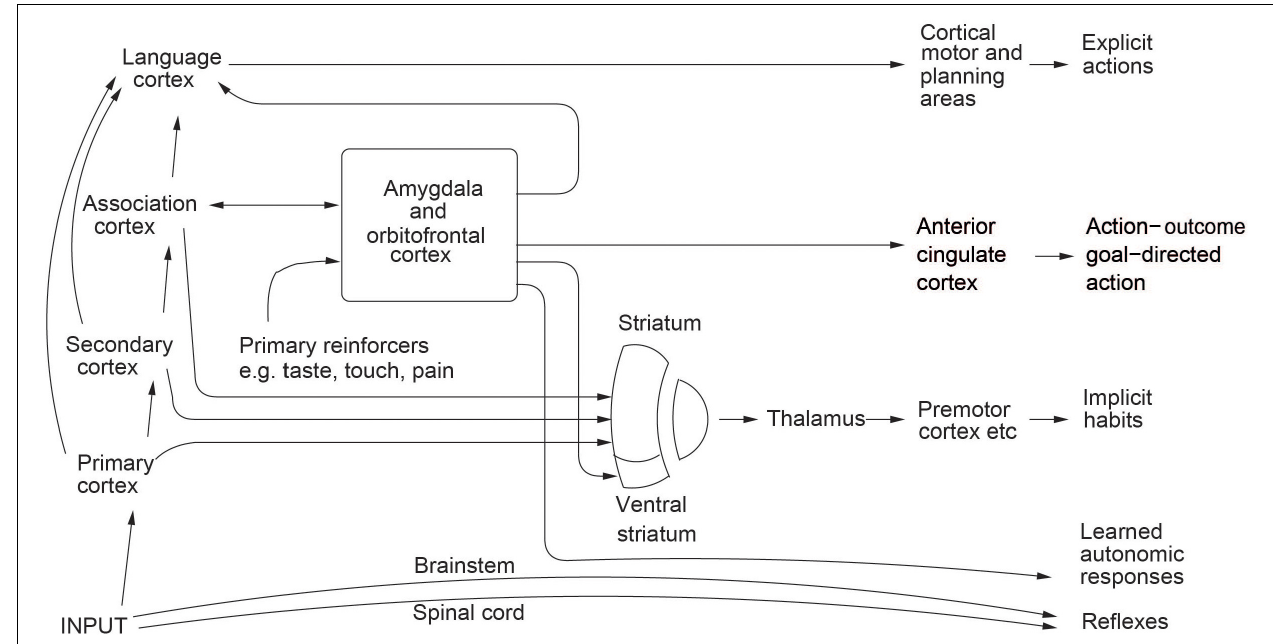
FIGURE 1 | Multiple routes to the initiation of actions and other behavioral responses in response to rewarding and punishing stimuli. The inputs from different sensory systems to brain structures such as the orbitofrontal cortex and amygdala allow these brain structures to evaluate the reward- or punishment-related value of incoming stimuli, or of remembered stimuli. One type of route is via the language systems of the brain, which allow explicit (verbalizable) decisions involving multistep syntactic planning to be implemented. The other type of route may be implicit, and includes the anterior cingulate cortex for action–outcome, goal-dependent, learning; and the striatum and rest of the basal ganglia for stimulus–response habits. The basal ganglia may be involved in selecting only one system for output. Outputs for autonomic responses can also be produced using outputs from the orbitofrontal cortex and anterior cingulate cortex (some of which are routed via the anterior insular cortex) and